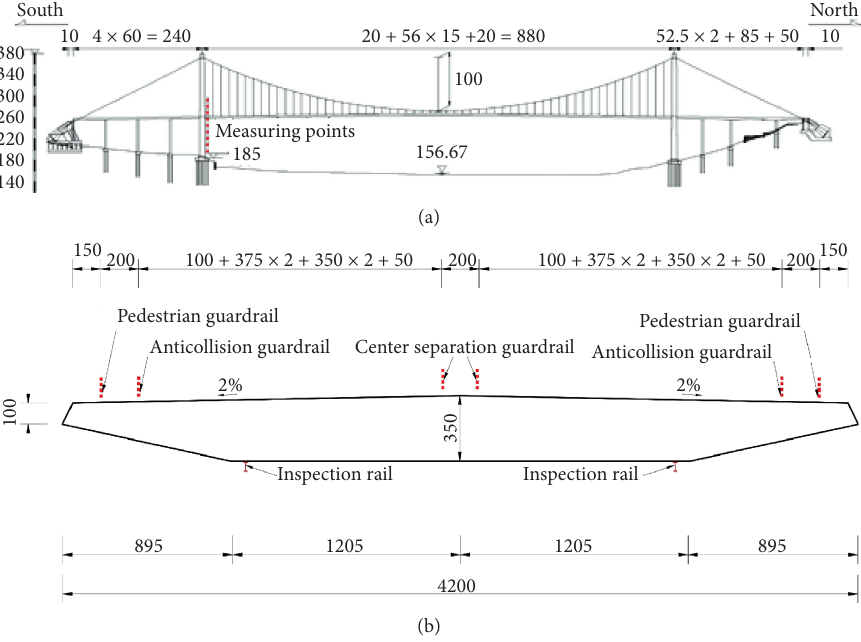
Figure 2: Dimensions of the bridge: (a) elevation view; (b) main